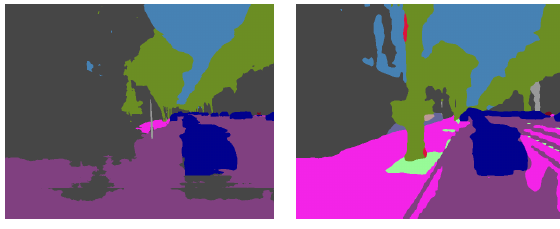
Figure 2. Predictions before (left) and after correction (right). We recovered the sidewalk (pink), terrain (light green), vegetation (green) and improved the overall mIoU by